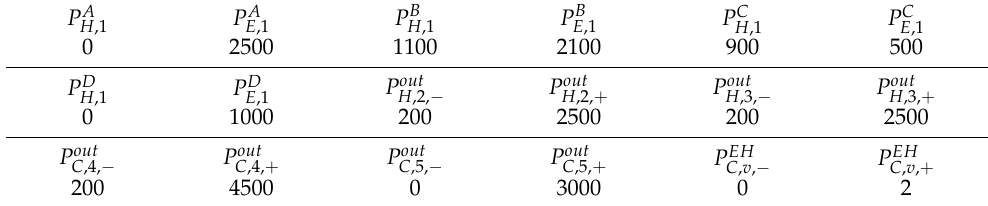
Table 3. Capacities of EH devices in the test system (kW).